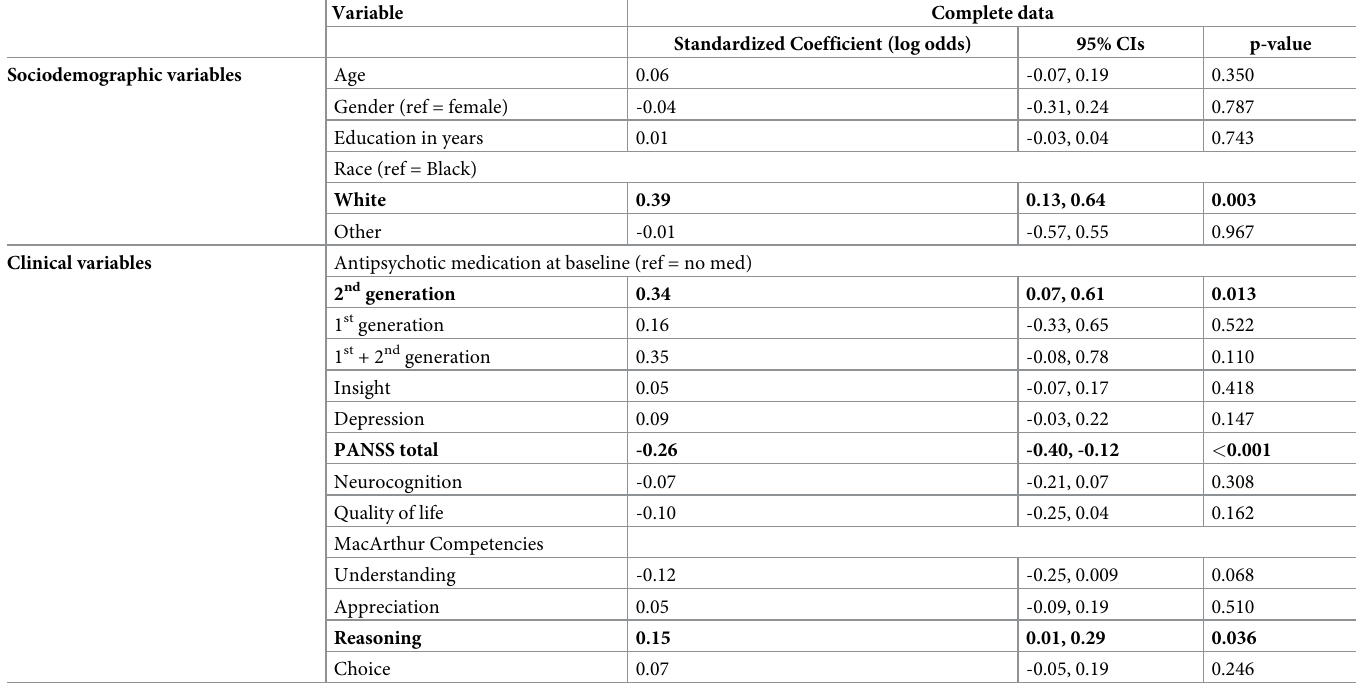
Table 3. Logistic regression results for baseline data (N = 1249).